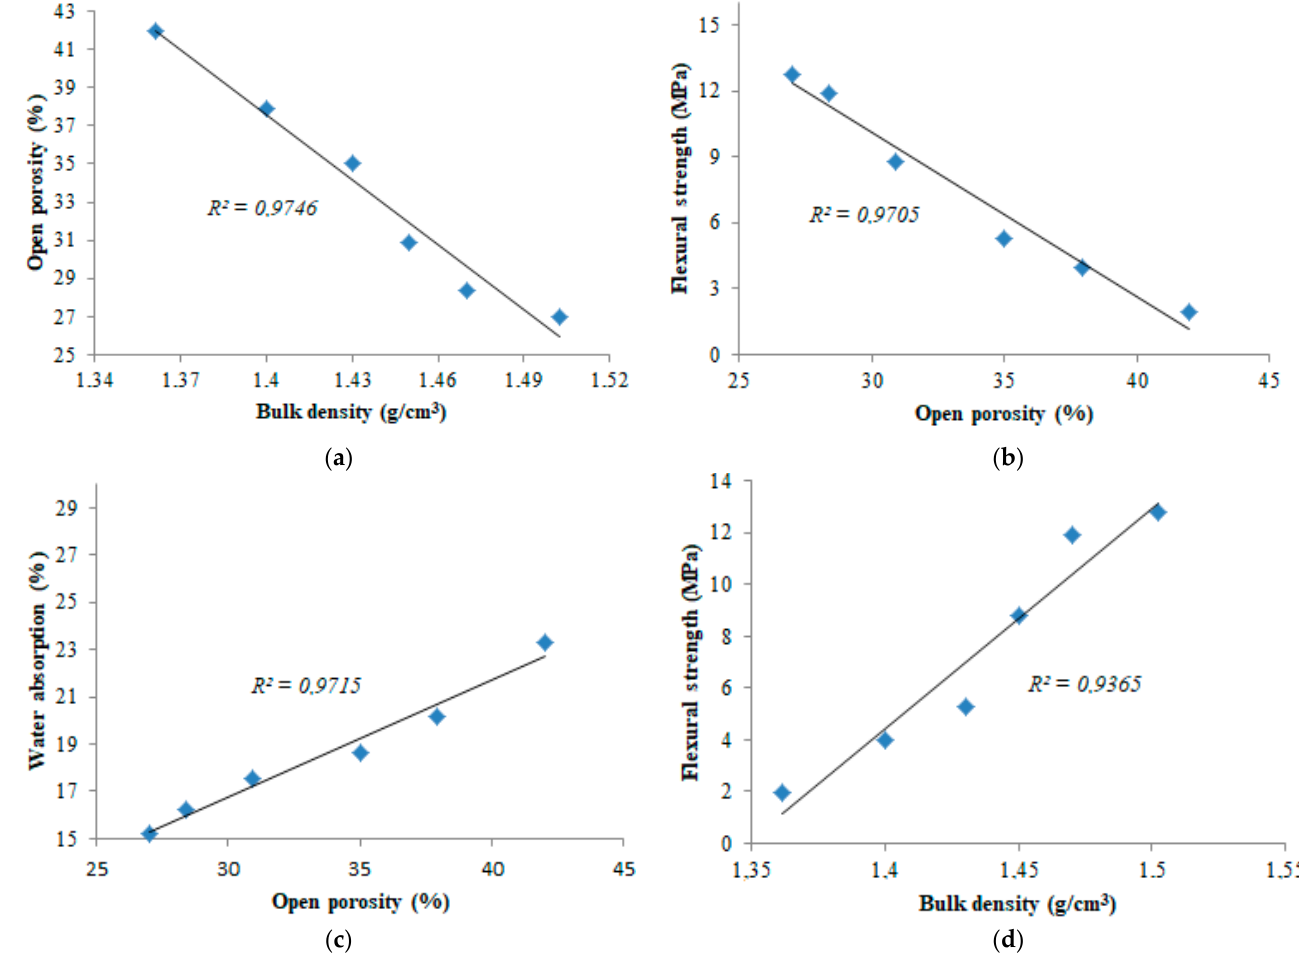
Figure 9. Correlation and linear regression of the different properties of bricks fired at 1050 °C.